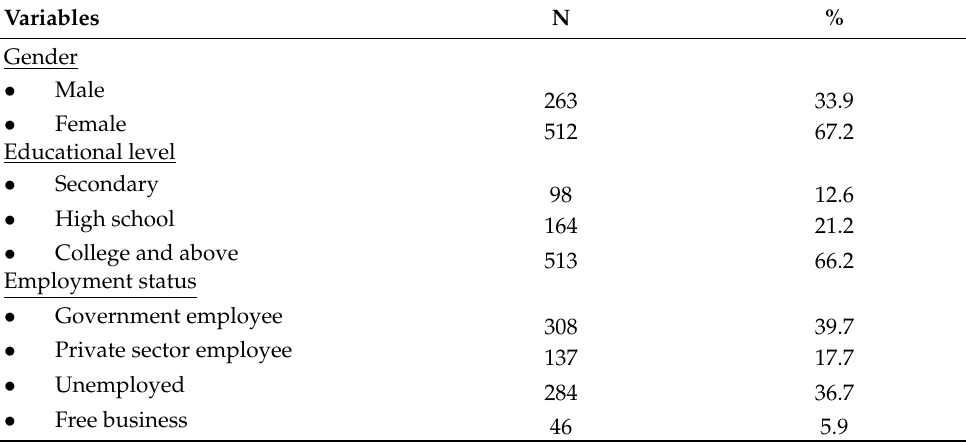
Table 1. Sociodemographic and clinical characteristics of the studied participants (N =